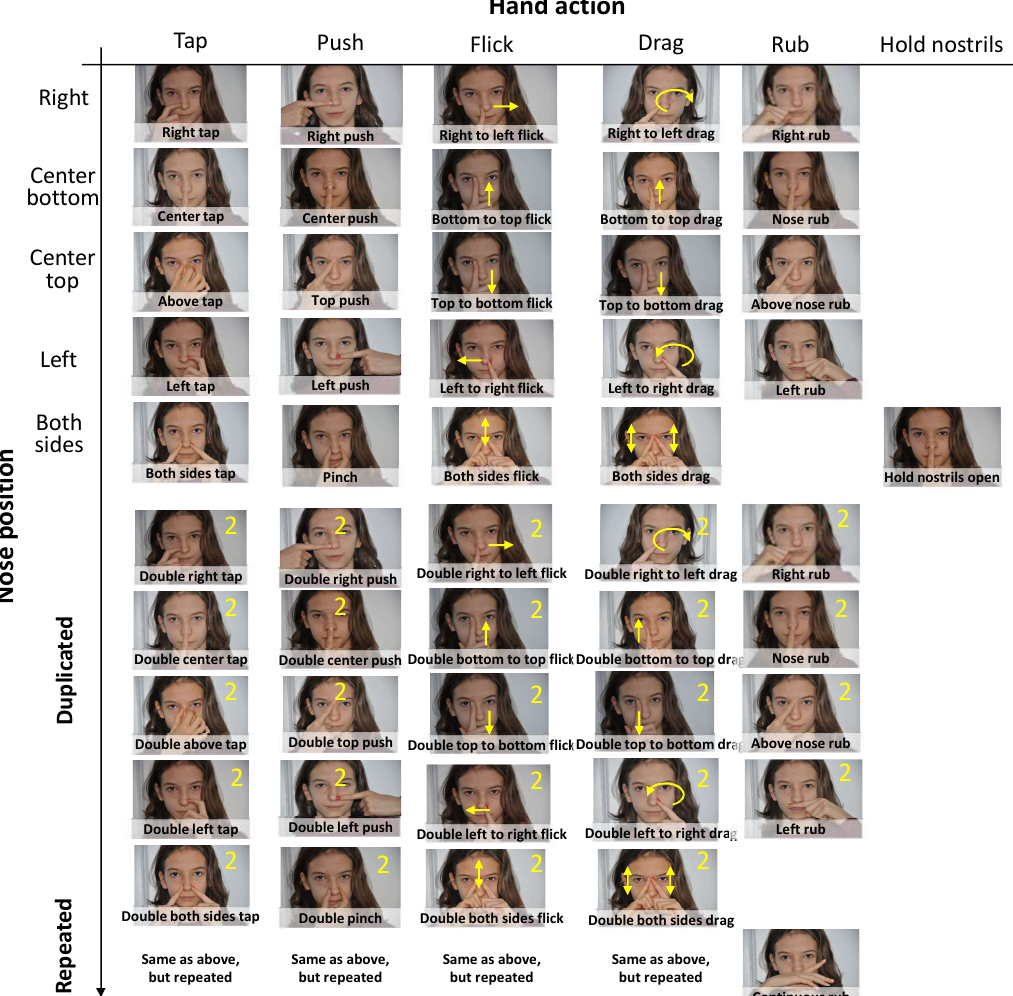
Figure 2. Taxonomy of nose-based gestures: by hand action, nose position, and factor of repetition. 1. Tap : tap any side of the dorsum nasi with the back or the top of one or several fingers with one hand (1.0), on the center (1.1), with two hands on both sides of the nose (1.2), repeated center tap (1.3), right tap (1.5), left tap (1.6). 2. Double tap : tap two times on the center (2.1), both sides of the nose (2.2), right (2.5), left (2.6), above the nose (2.7). 3. Triple tap : tap three times in a row on the center (3.1), right (3.5), left (3.6), above (3.7). 4. Flicking : from right to left (4.5), from left to right (4.6), from the top of the dorsum nasi to the bottom (4.7). 5. Pushing : center push (5.1), right push (5.5), left push (5.6). 6. Rubbing : rub once on right/left side (6.5/6.6), above the nose (6.7), continuous rub on the right/left (8.8/8.9). 7. Double rubbing : repeat rubbing two times in a row. 8. Triple rubbing : repeat rubbing three times in a row. 9. Drag : stays pressed from the initial point to the final one with the right (9.1) or left hand (9.2), from bottom to top (9.3) or vice versa (9.4), from right to left (9.5) or inverse (9.6). 10. Double drag : on the right (10.5), on the left (10.6), from bottom to top (10.7), from top to bottom (10.8). 11. Triple drag : drag repeated three times in a row. 12. Quadruple drag : drag repeated four times in a row. 13. Pinch : when two fingers come far from each